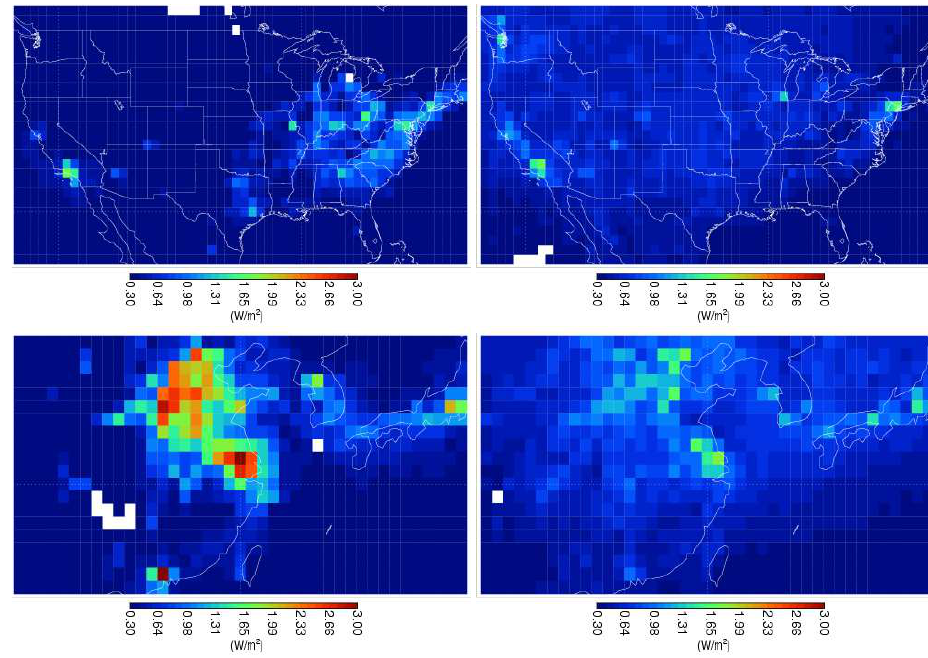
Fig. 8. Clear-sky daily maximum net atmospheric heating for January (left) and July (right) 2005 over the US (top) and Southeast Asia (bottom).